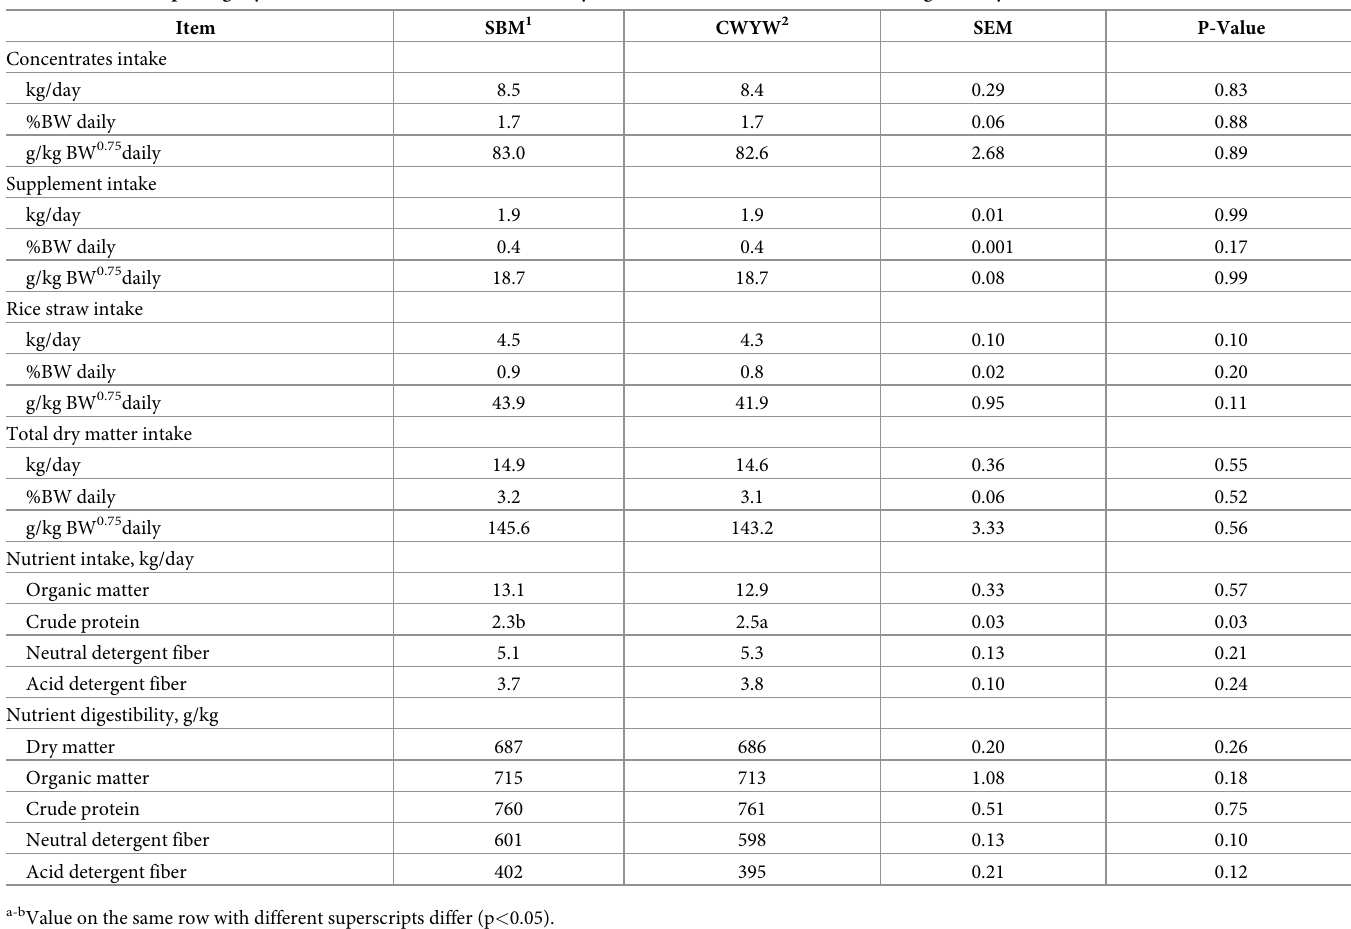
a-b Value on the same row with different superscripts differ (p <